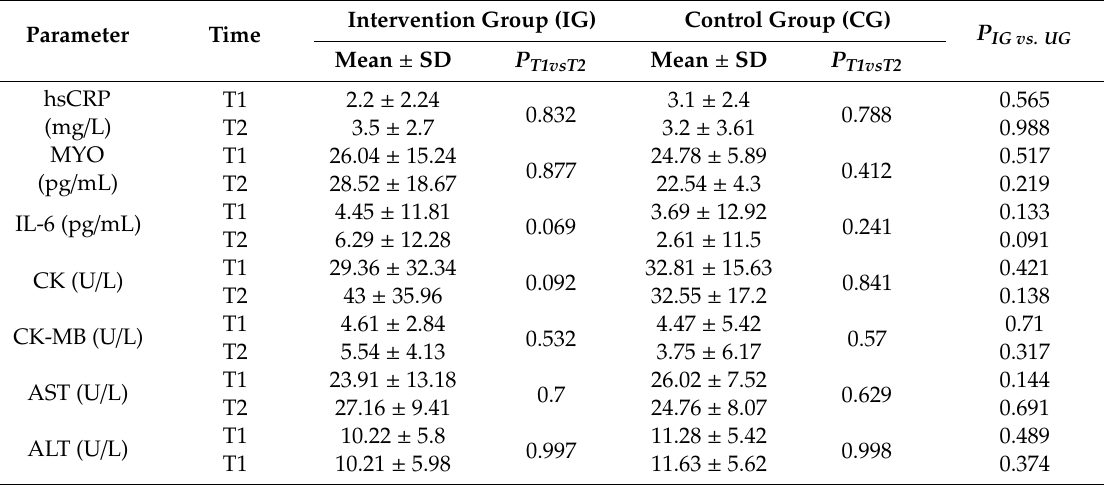
Table 4. Comparison of the blood parameters between the study groups.